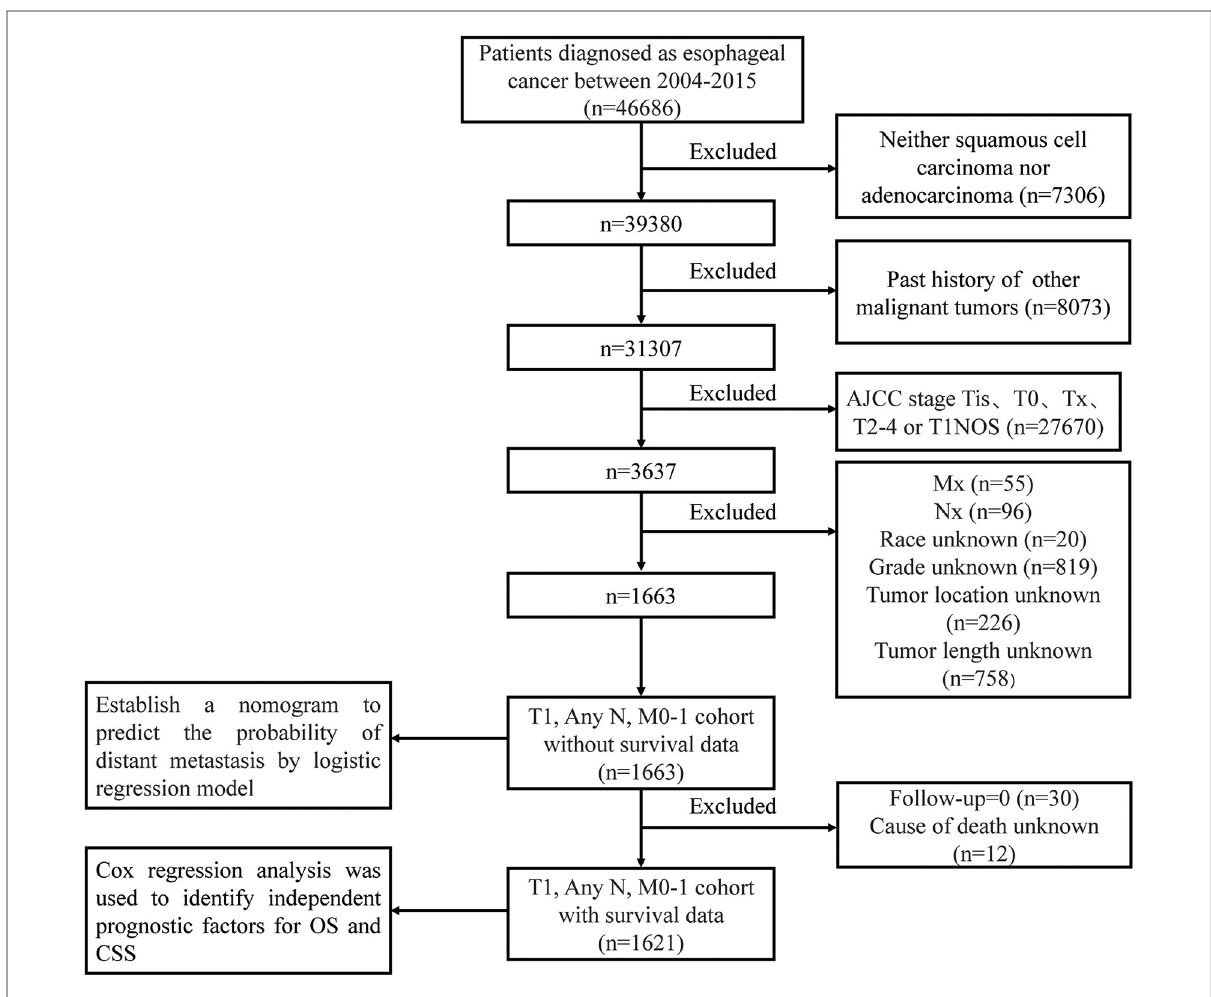
FIGURE 1 Patient enrollment fl